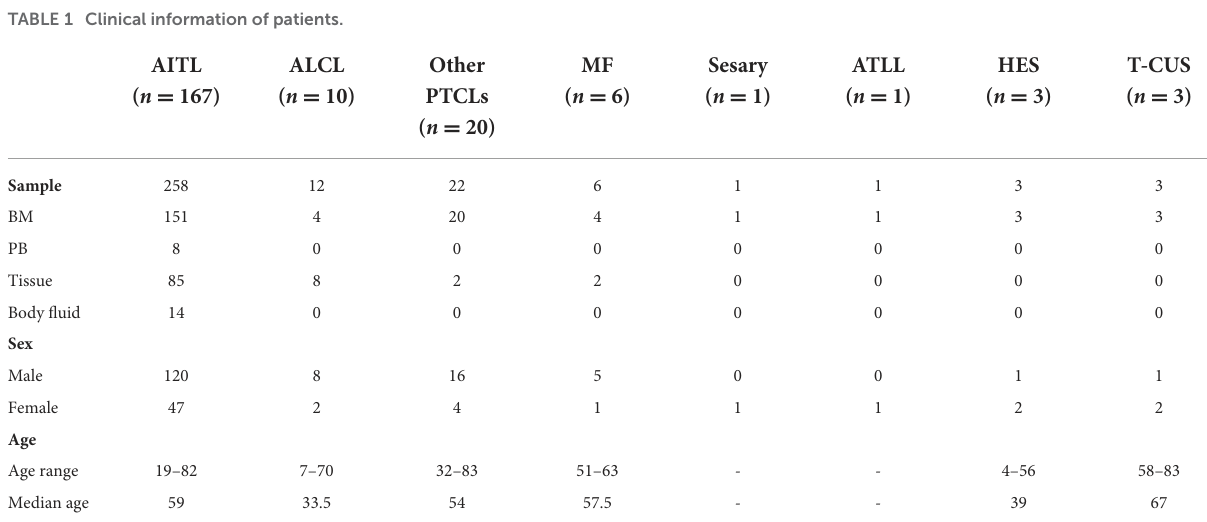
Table 2. The coexistence of surface CD3-positive and